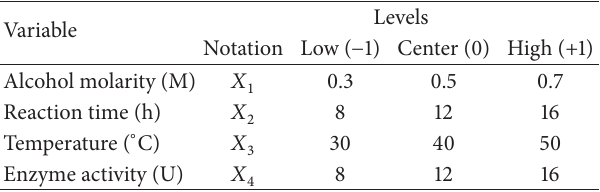
Table 1: Transesterification variables and their levels.